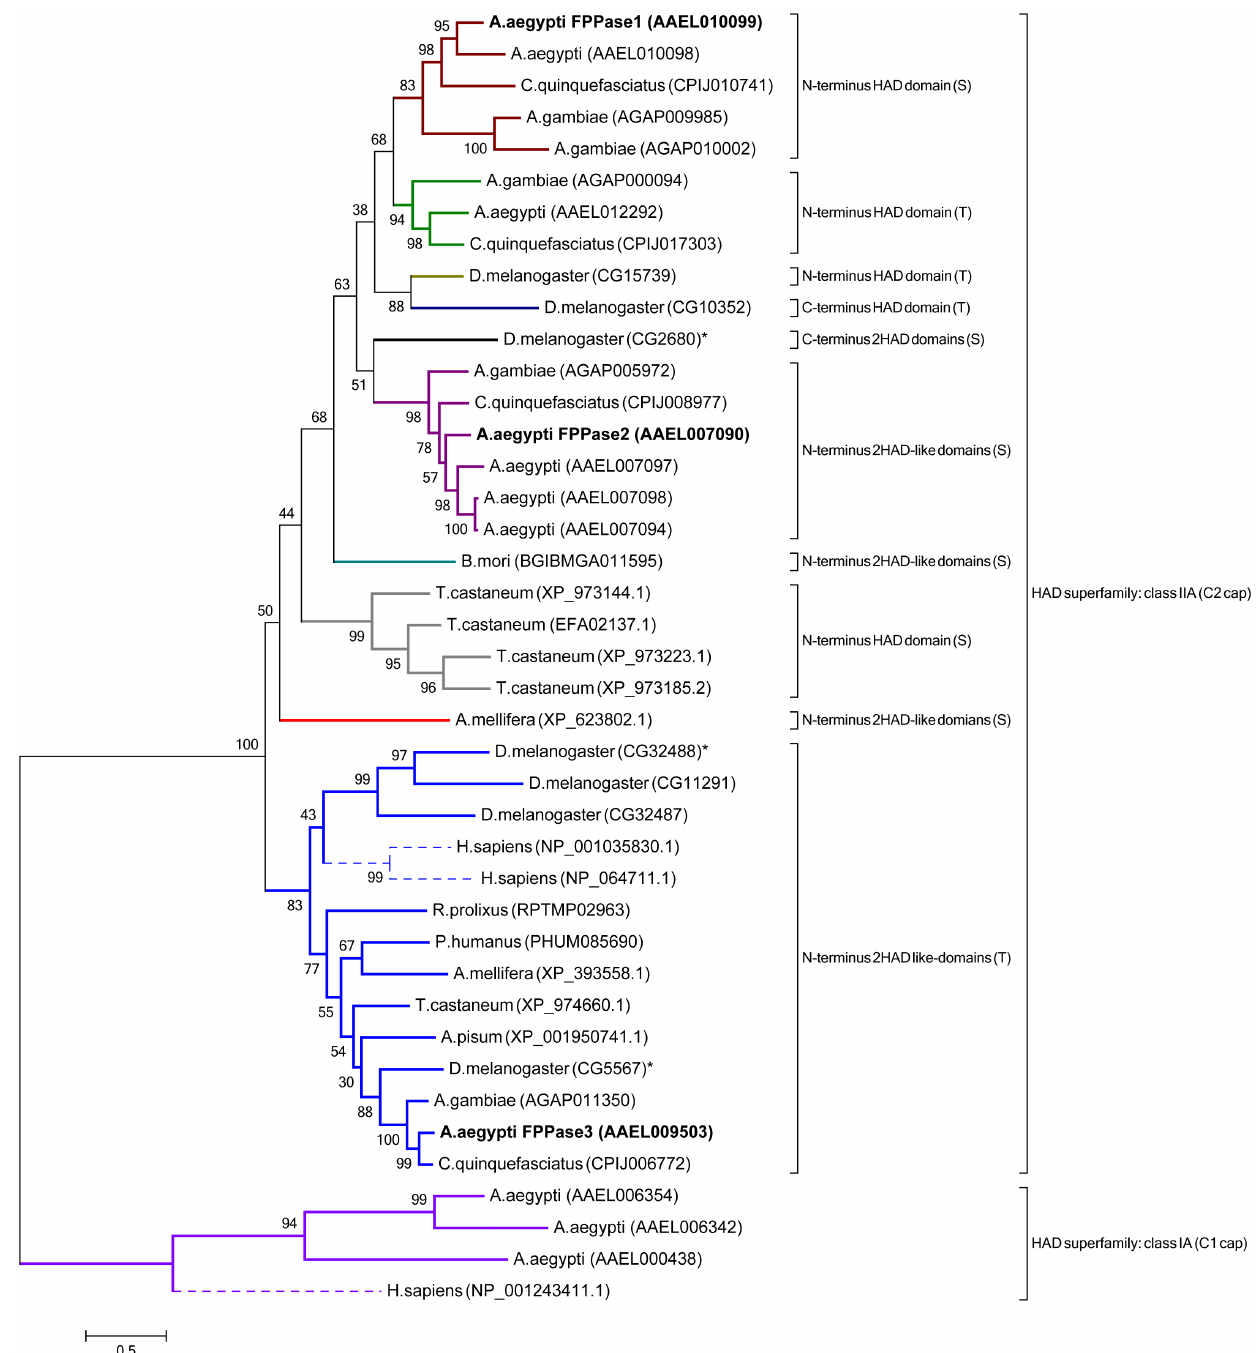
Figure 2. Phylogenetic analysis of HAD superfamily sequences from insects and human. Sequences are labeled with species names and accession numbers in between brackets. The bifunctional human epoxy hydrolase (NP_001243411.1) was used as outgroup. Sequences grouped in two clades. All sequences in Clade 1 are members of the NagD family included in the class IIA of HAD proteins. Sub-clades are separated by the localization of the HAD domain and the presence of a Ser (S) or Thr (T) in motif II. The position of the functional domain is referred as N-terminus or C- terminus. Insects with two potential HAD functional domains are shown with an asterisk. Bold labels represent the Aa FPPase- 1, Aa FPPase-2 and Aa FPPase-3. Human sequences are represented by dotted lines in the tree. All sequences in Clade 2 are epoxy hydrolases, which are members of the class IA of HAD proteins.